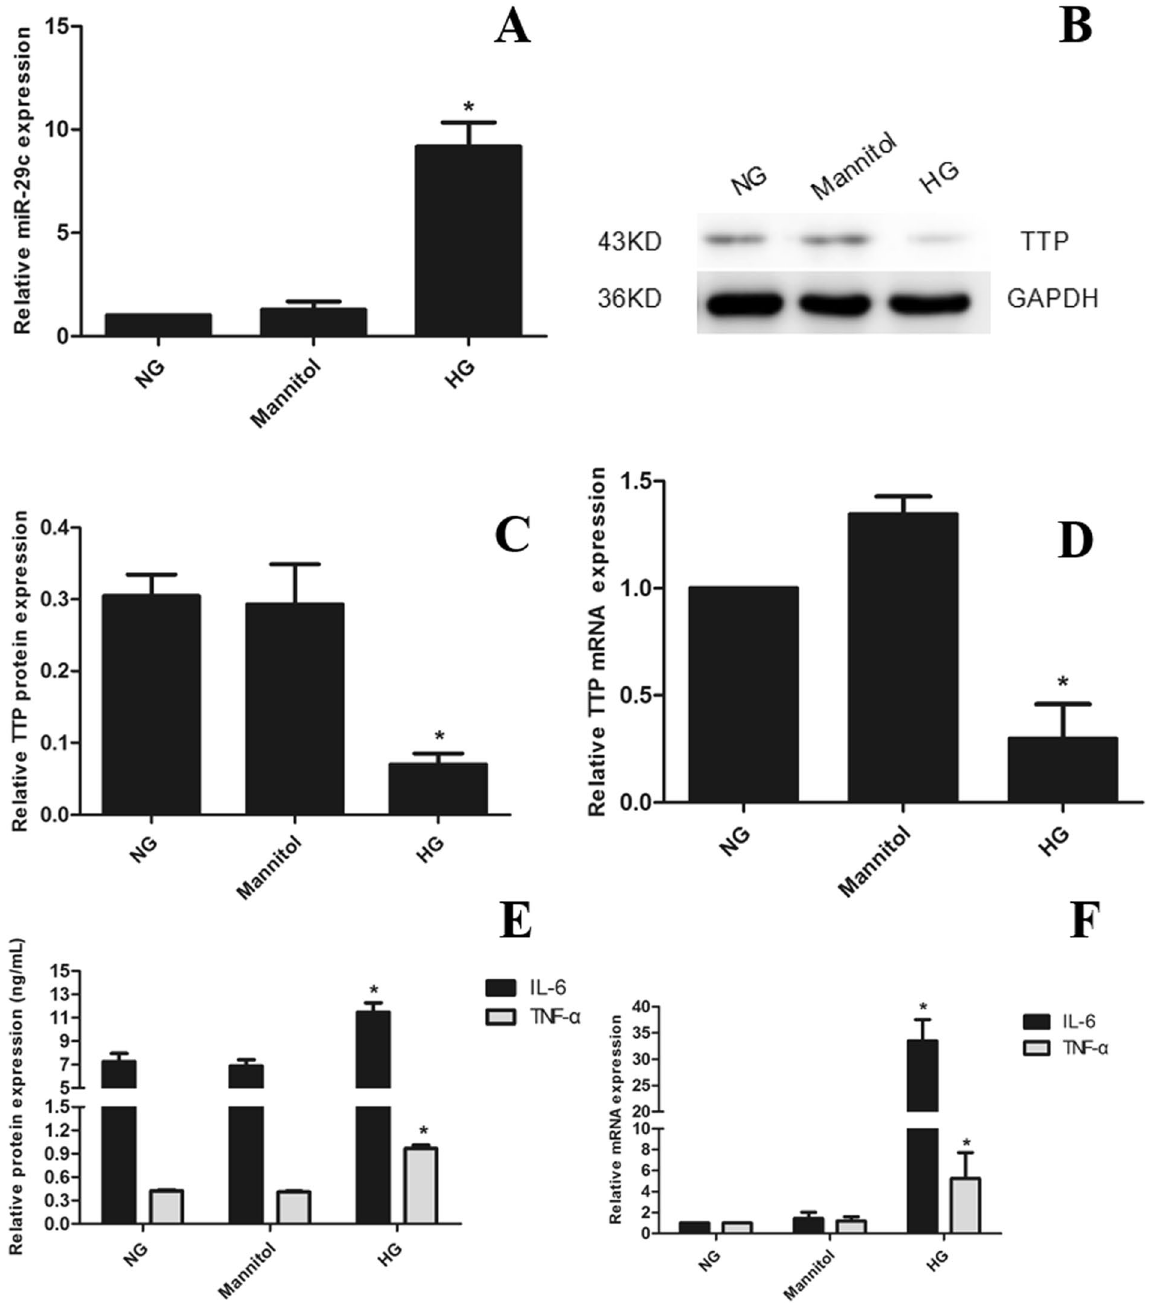
Figure 4. Up-regulation of miRNA-29c and inflammatory cytokines and down-regulation of TTP in podocytes. ( A ) Real-time qPCR analysis shows miRNA-29c expression in podocytes treated with high glucose (25 mM) for 6 h as com-pared with podocytes treated with either normal glucose (5.6 mM) or mannitol (25 mM). Measured transcript levels were normalized to U6 snRNA expression. ( B ) Podocytes were cultured in high glucose for 24 h as compared with normal glucose or mannitol, TTP protein expression was assessed by Western blot, GAPDH served as an internal control. ( C ) The quantified Western blot data shown in graph format. ( D ) qRT-PCR analysis of TTP mRNA expression in hyperglycemic condition. ( E ) IL-6 and TNF- α protein expression by ELISA analysis in hyperglycemic condition for 48 h. ( F ) qRT-PCR analysis of TTP mRNA expression in hyperglycemic condition. Results were obtained from three independent experiments. Data are shown as mean ± SEM (n = 3). * P < 0.05 compared with